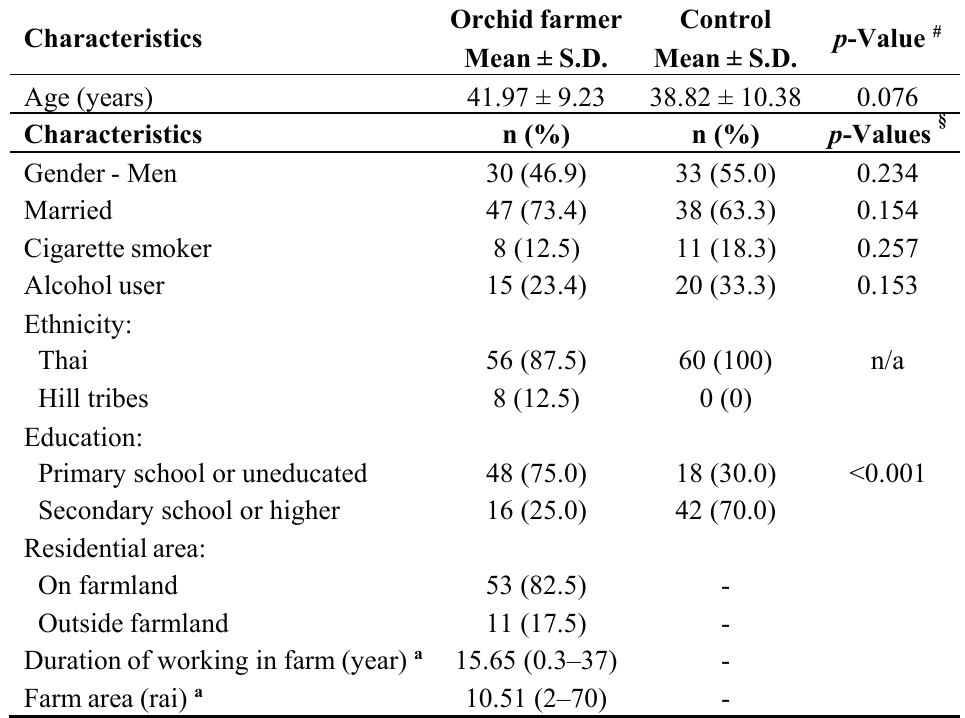
Table 1. Descriptive characteristics of orchid farmers ( n = 64) and control populations ( n = 60) participated in the